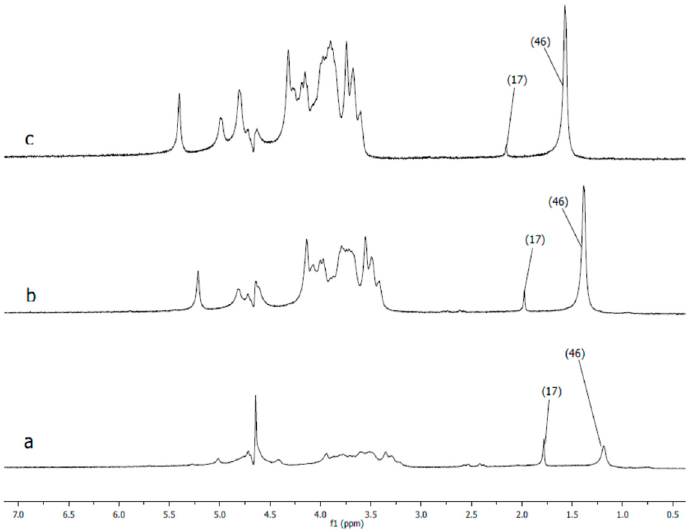
Figure 14. 1 H nuclear magnetic resonance (NMR) spectra of 1 wt % gellan in D 2 O at 25 ( a ), 45 ( b ), and 65 °C ( c ) [46].